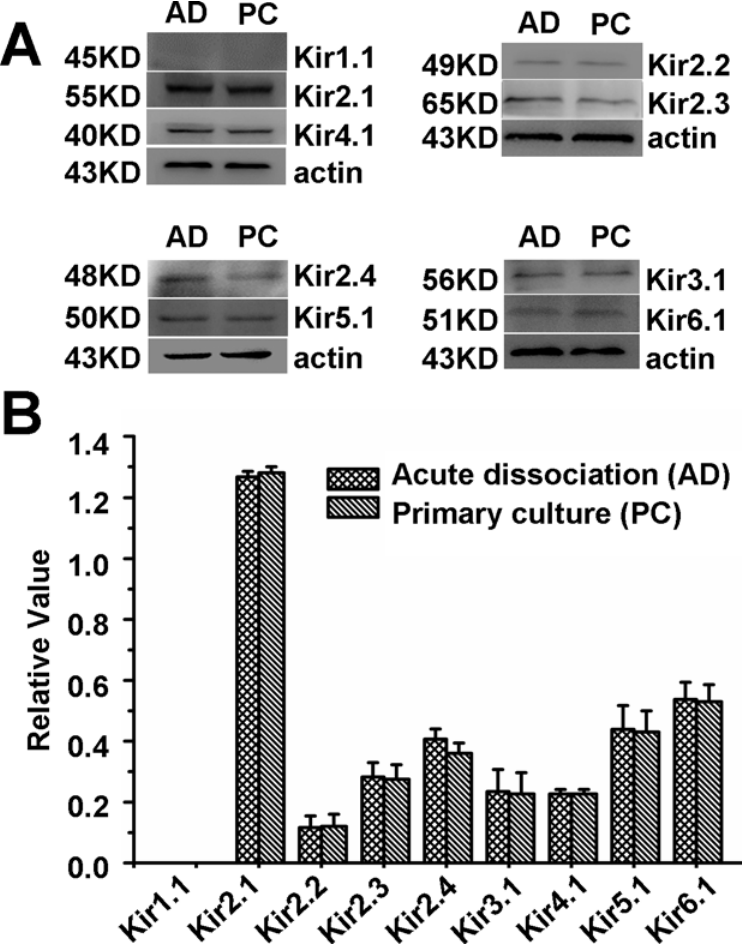
Fig 4. Western blot data analyses for Kir channels. (A) Kirs protein was detected in PAECs of acute dissociation (AD) and primary culture (PC). (B) Expression of Kir 2.1 was significantly more prominent than other subtypes of Kir channels and there were no significant difference of Kirs expression between AD and PC (P <